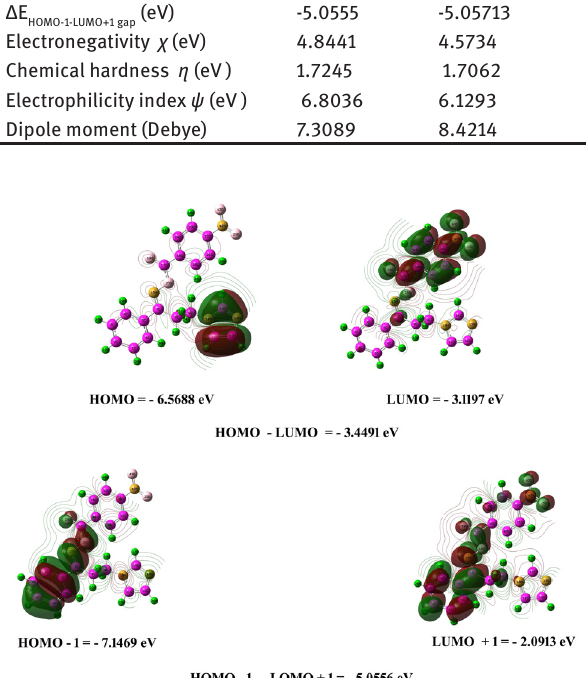
Figure 5: The molecular orbitals and energies for the HOMO-1, HOMO, and LUMO and LUMO+1 of the IPAONM